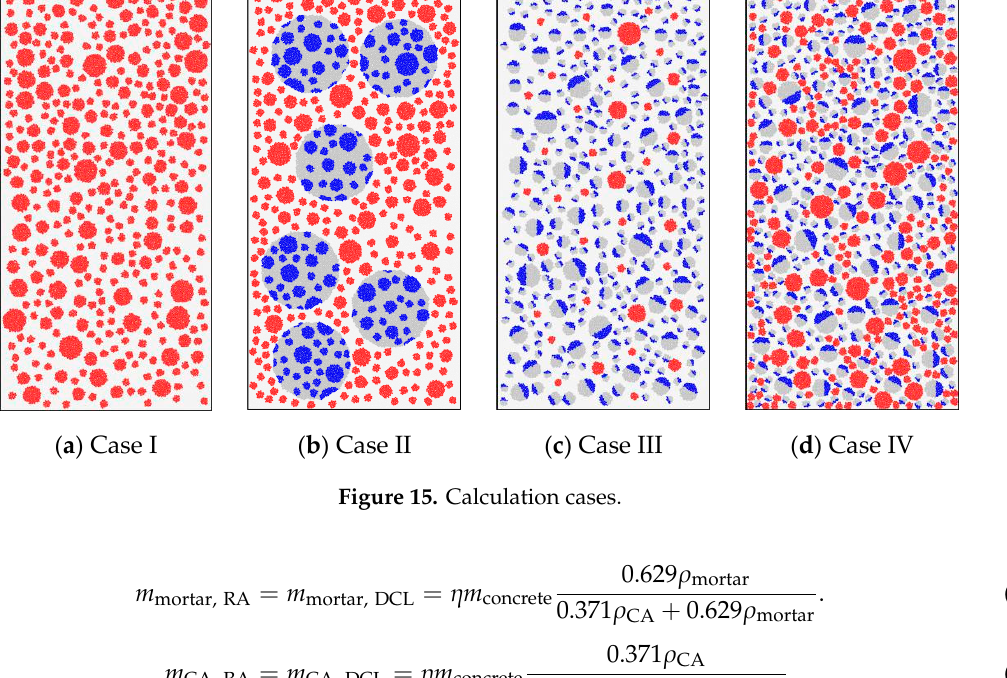
Figure 15. Calculation cases.